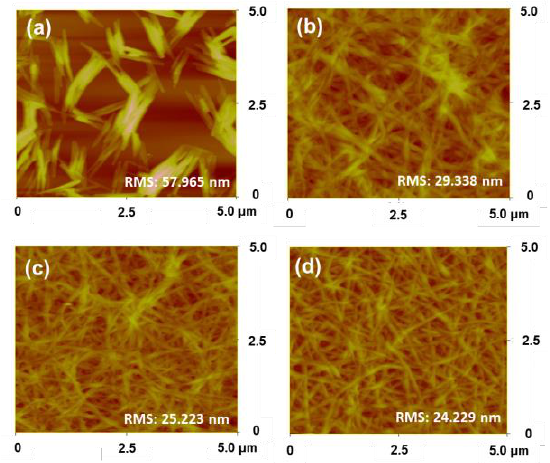
Figure 3. AFM images of the synthesized azo pyridone derivatives obtained after spin coating: ( a ) M-PAMOPC, ( b ) F-PAMOPC, ( c ) Cl-PAMOPC, and ( d ) Br-PAMOPC.